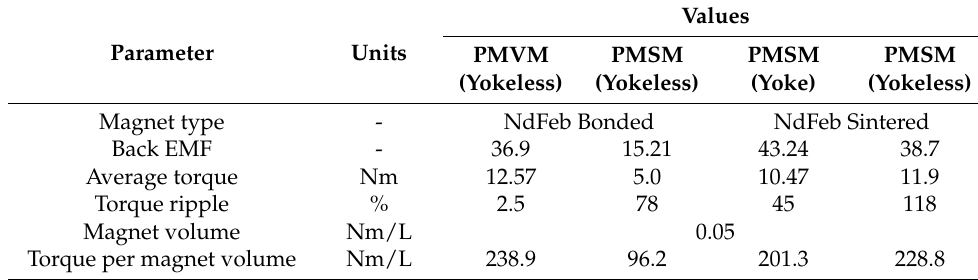
Table 3. Performance comparison of DARF-PMVM with iron yoke and yokeless rotor models.